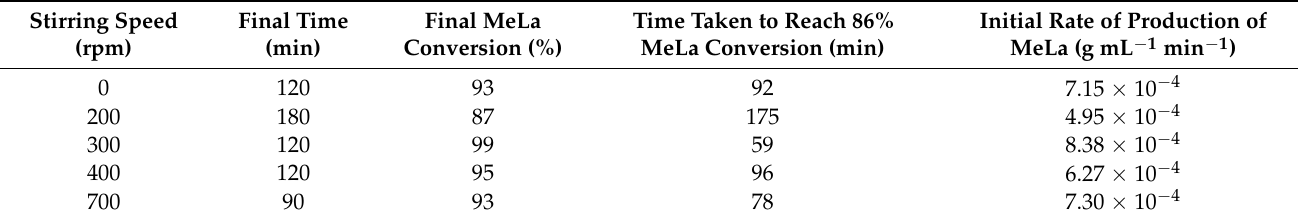
Table 2. Methanolysis of PLA at 130 ◦ C 0.025 g DMAP + 0.075 g ZnAc, effect of different stirring speeds on final time (min), final MeLa conversion (%), time taken to reach 86% MeLa conversion, initial rate of production of MeLa (g mL − 1 min − 1